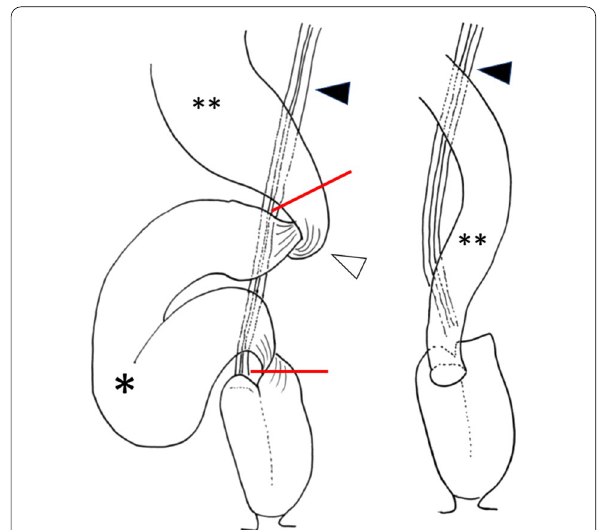
Fig. 9 The dilated ileum that contained the volvulus was excised only on the oral side of the pouch, with a length of 18 cm, and an intraluminal anastomosis was performed on the anterior wall of the pouch using a circular stapler. *: ileal volvulus, **: dilated proximal ileum, black up-pointing triangle: superior mesenteric artery and vein, white up-pointing triangle: adhesion to the